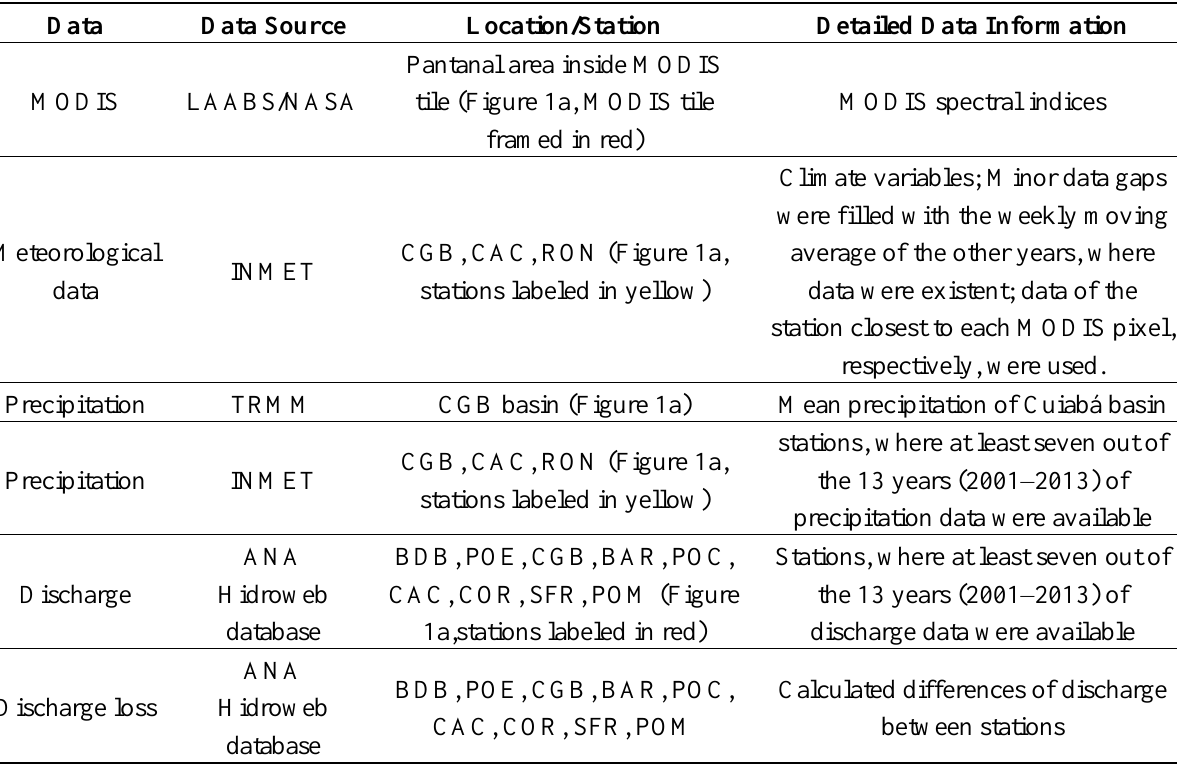
Table 2. Data used for investigating the impact of local and upstream changes as well as data source, name of location/station (Figure 1) and detailed data